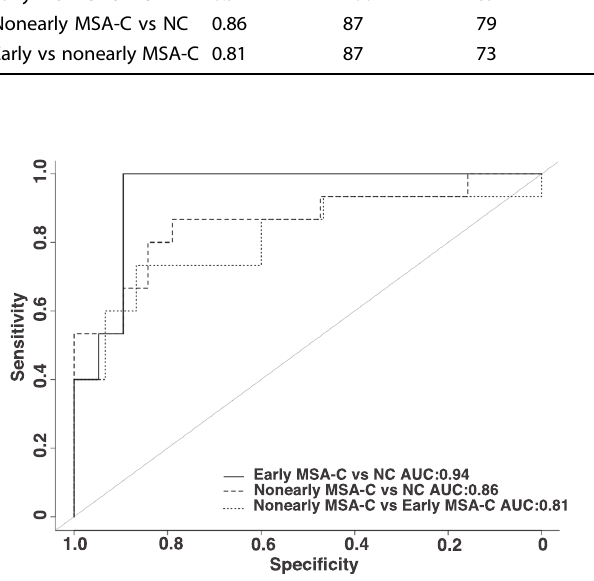
Fig. 5 Receiver operating curves of the classi fi cation models for discriminating MSA-C and NC. Different models are plotted with different line styles. Discrimination between the early-stage patients and NCs achieved the best performance among the three